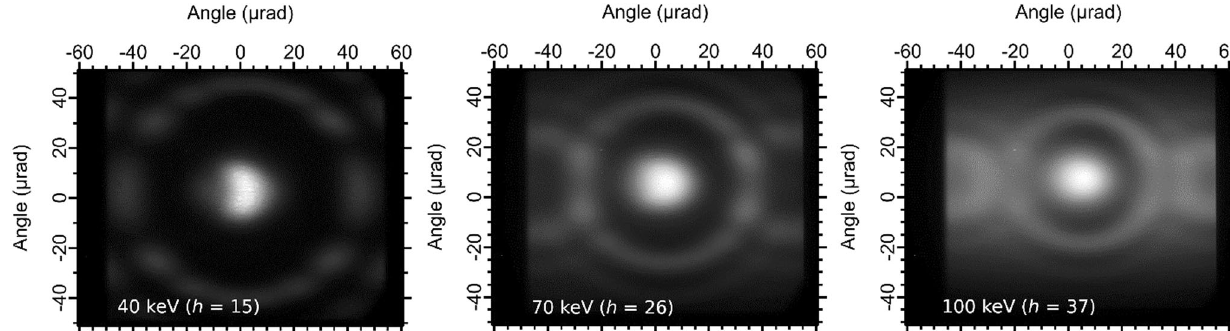
Fig. 7 Undulator beam images. Monochromatic beam images of a 1.6 m long, U35 undulator source (35 mm period) with de fl ection parameter K = 2.293, recorded on beamline ID15A at 40.4 keV (15th harmonic), 69.9 keV (26th harmonic) and 99.5 keV (37th harmonic). The images were recorded at a distance of 65 m with a PCO-edge camera coupled to a 2× optics and a LuAG:Ce scintillator. The image pixel size is 3.18 μ m pixel. The central disks are the main harmonics (e.g., the 15th harmonic at 40 keV) and the rings are higher-order harmonics (e.g., the 16th harmonic at 40 keV).